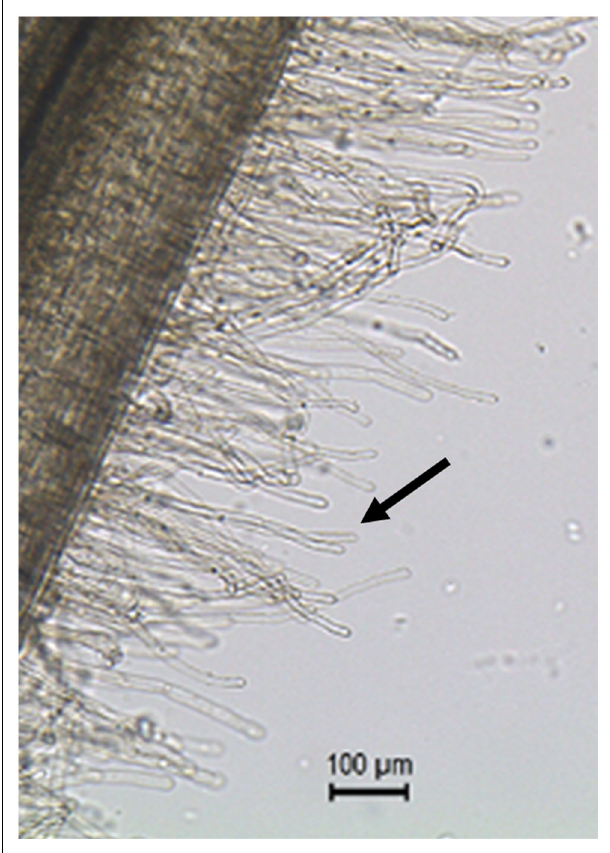
FIGURE 1 | Root hair cells (black arrow pointing at one of the root hair cells) are single tubular root cells. Their distinctive lateral elongation increases the surface of exchange between the plant’s root system and the soil.The main function of root hairs is the uptake of water and nutrients from the